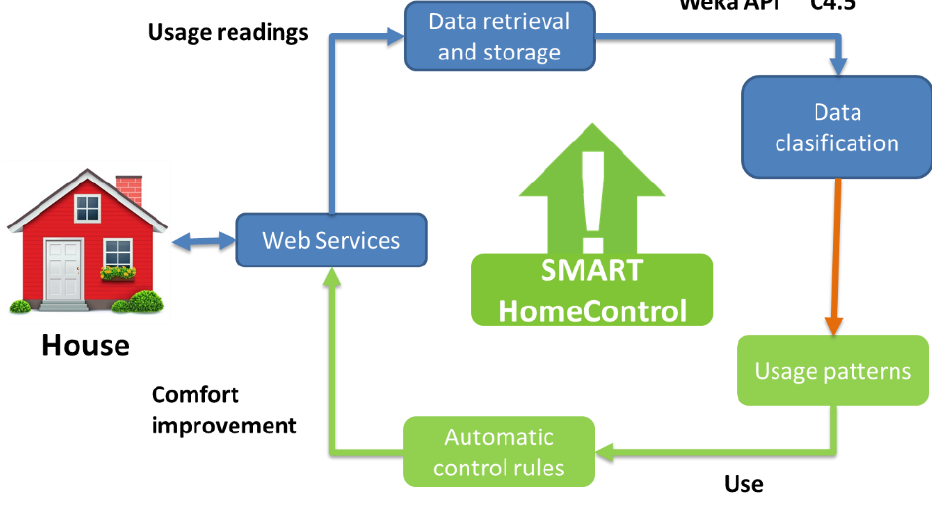
Figure 2. Smart Home Control’s workflow.